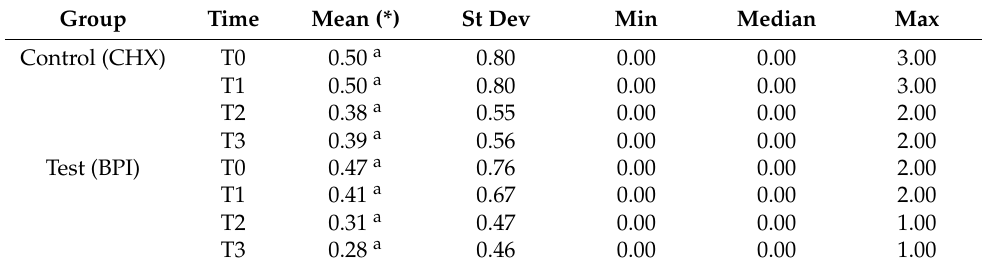
Table 3. Descriptive statistics of dental mobility.